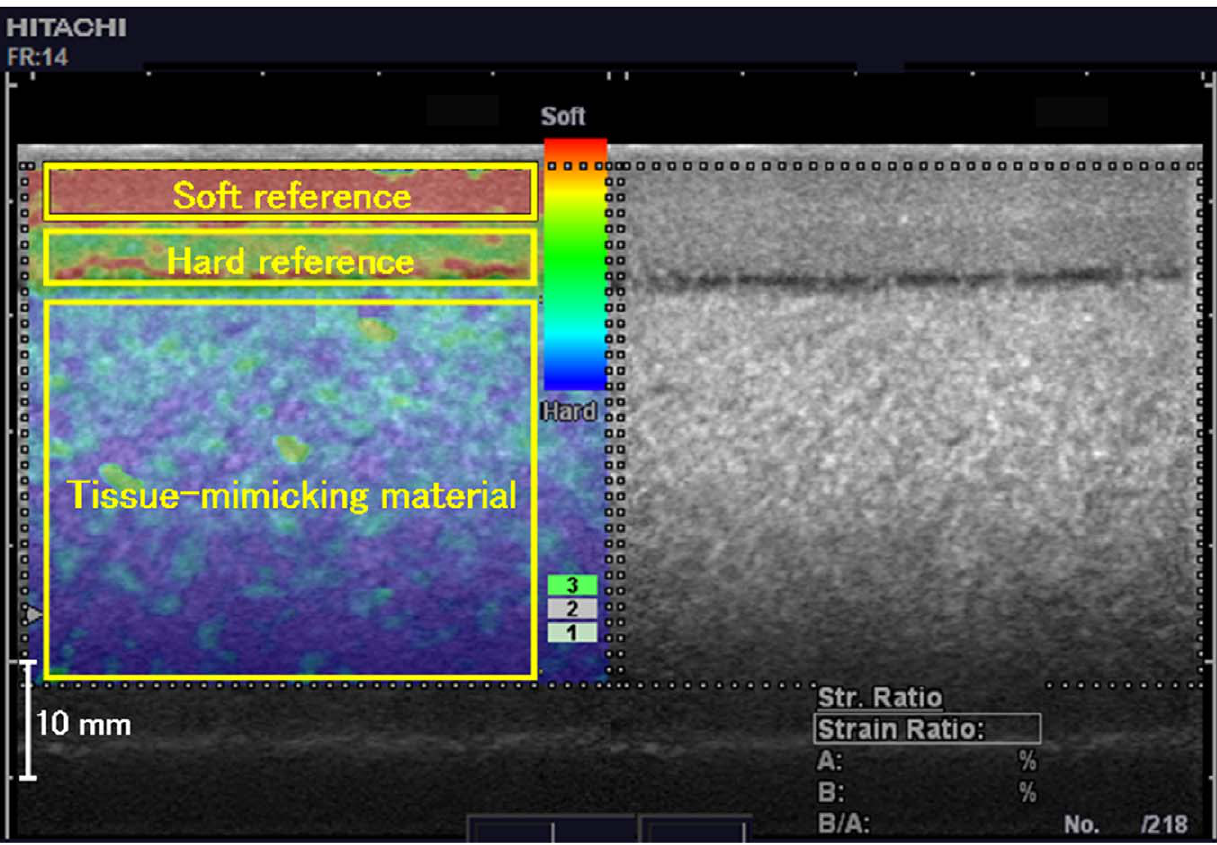
Figure 1. Typical ultrasound elastogram of the tissue-mimicking material. The image on the left is a color-coded elastogram superimposed on a conventional B-mode ultrasound image, whereas that on the right side is the B-mode ultrasound image. On the elastogram, a color-coded scale from red (soft) to blue (hard) and a numeric scale of 1–7 indicating the velocity of the compression–relaxation cycles are presented. Regions of interest within the soft mimicking reference (7 kPa), hard mimicking reference (30 kPa), and tissue-mimicking materials (50 kPa) are indicated by the yellow rectangles.